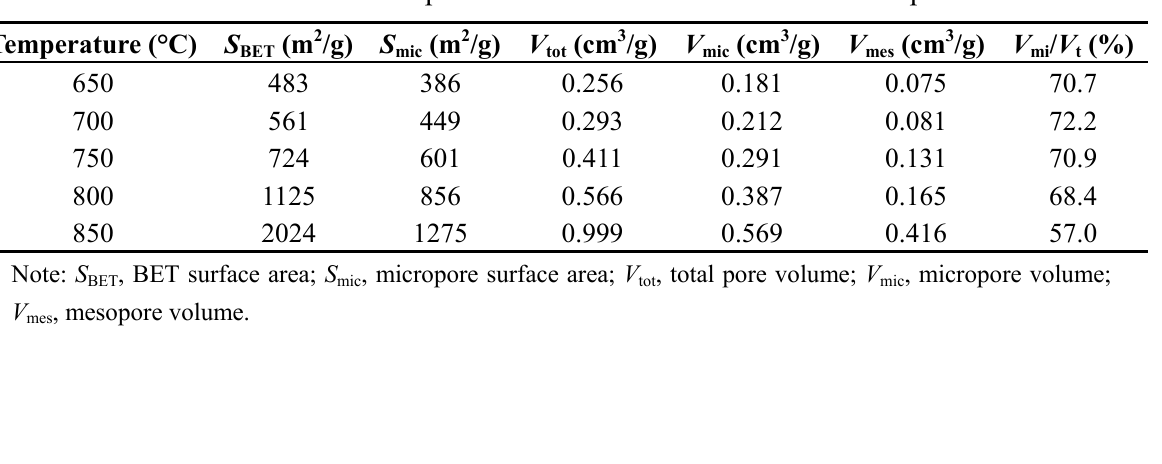
Table 4. Surface areas and pore volumes of BACFs at different